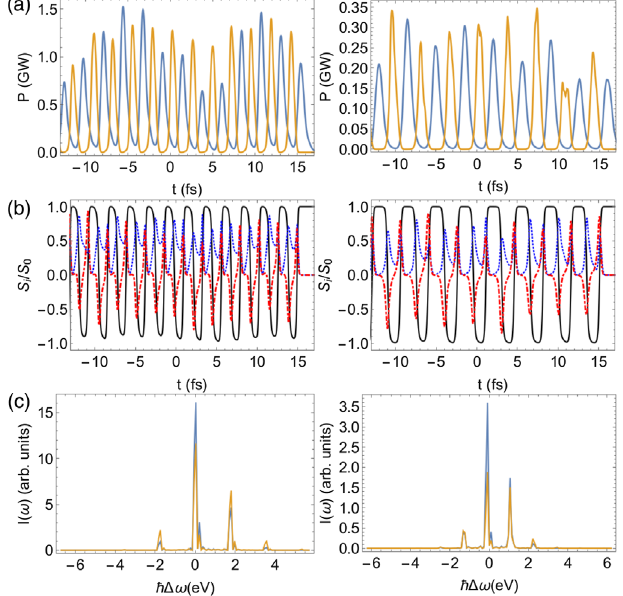
FIG. 7. Temporal modulation produced with single color regular self-seeding plus current modulation. Left: 700 nm modulation Right: 1050 nm modulation. Top: power in s -polarization (blue) and p -polarization (yellow). Middle: nor- malized Stokes parameters, S 1 =S 0 (black, line), S 2 =S 0 (blue, dotted), S 3 =S 0 (red, dashed). Bottom: on-axis spectral intensity in s -polarization (blue) and p -polarization